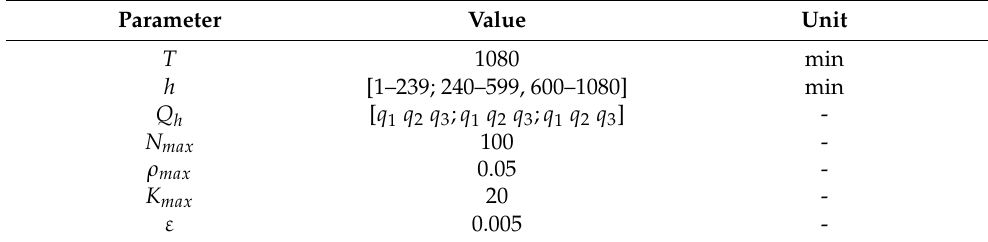
Table 7. Values of parameters in